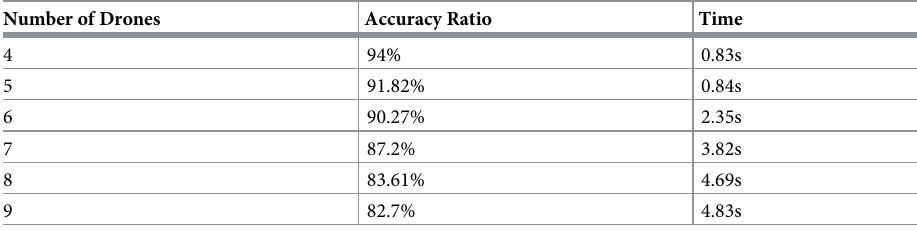
Table 6. Classification rate with various numbers of